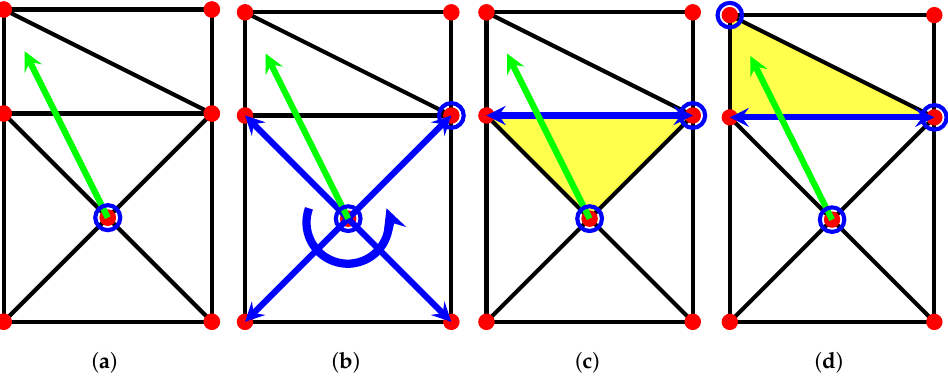
Figure 7. Reconstruction of feature edges. ( a ) Start point search. ( b ) Right most edge. ( c ) Next triangle edge. ( d ) Opposite